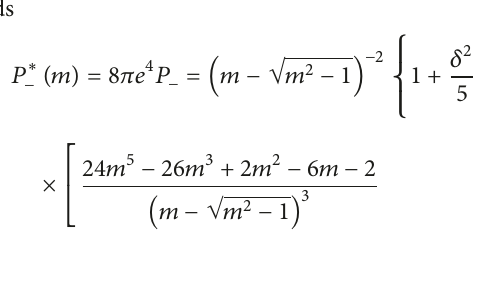
which by inserting (22) and using some simple calculations reads